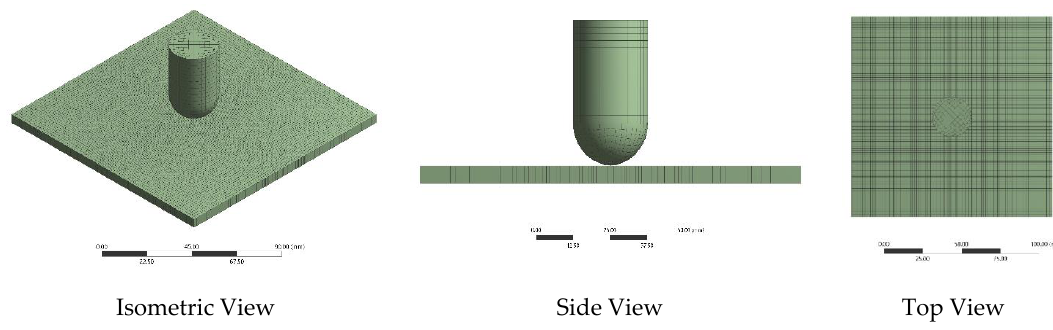
Figure 11. Impact testing modeling using ANSYS LS-DYNA.